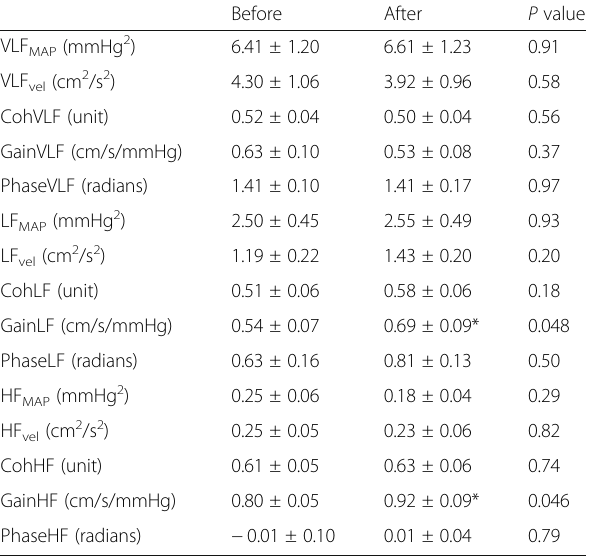
Table 2 Spectral and transfer function analysis Before After